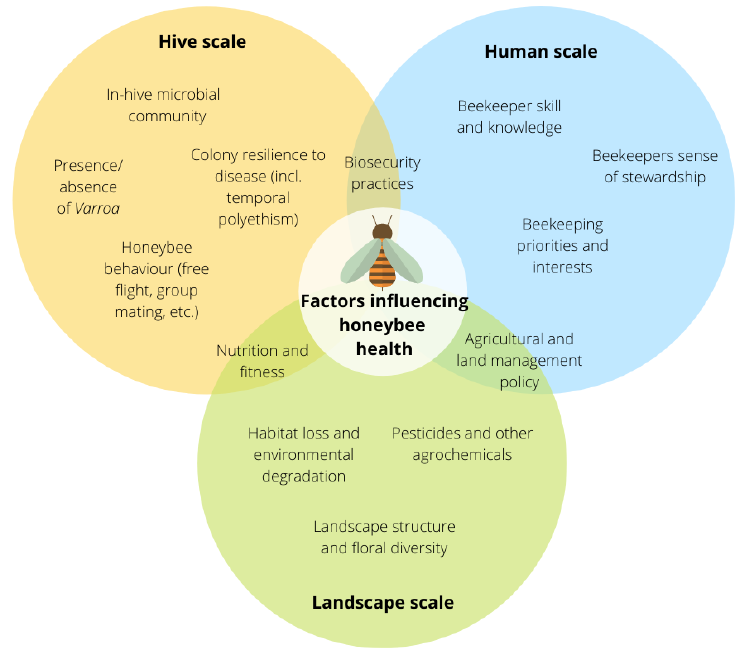
Figure A1. Factors influencing honey bee health at di ff erent scales. While factors at di ff ering scales have predominant impacts on honeybee health, points of overlap illustrate the need for a One-Health approach to address challenges to honeybee health. Table A1. Microbial, parasitic and commensal organisms associated with honeybees. Organism Type of Relationship